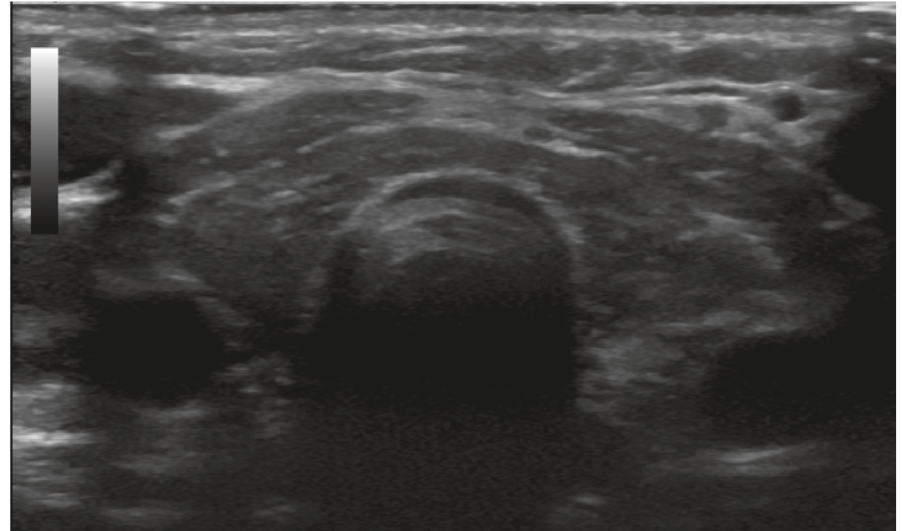
Figure 2: Thyroid ultrasound showing the relatively small size of the lobes and isthmus, diffuse coarse, heterogenous parenchymal echotexture with multiple fibrous echogenic lines, and no focal nodule.